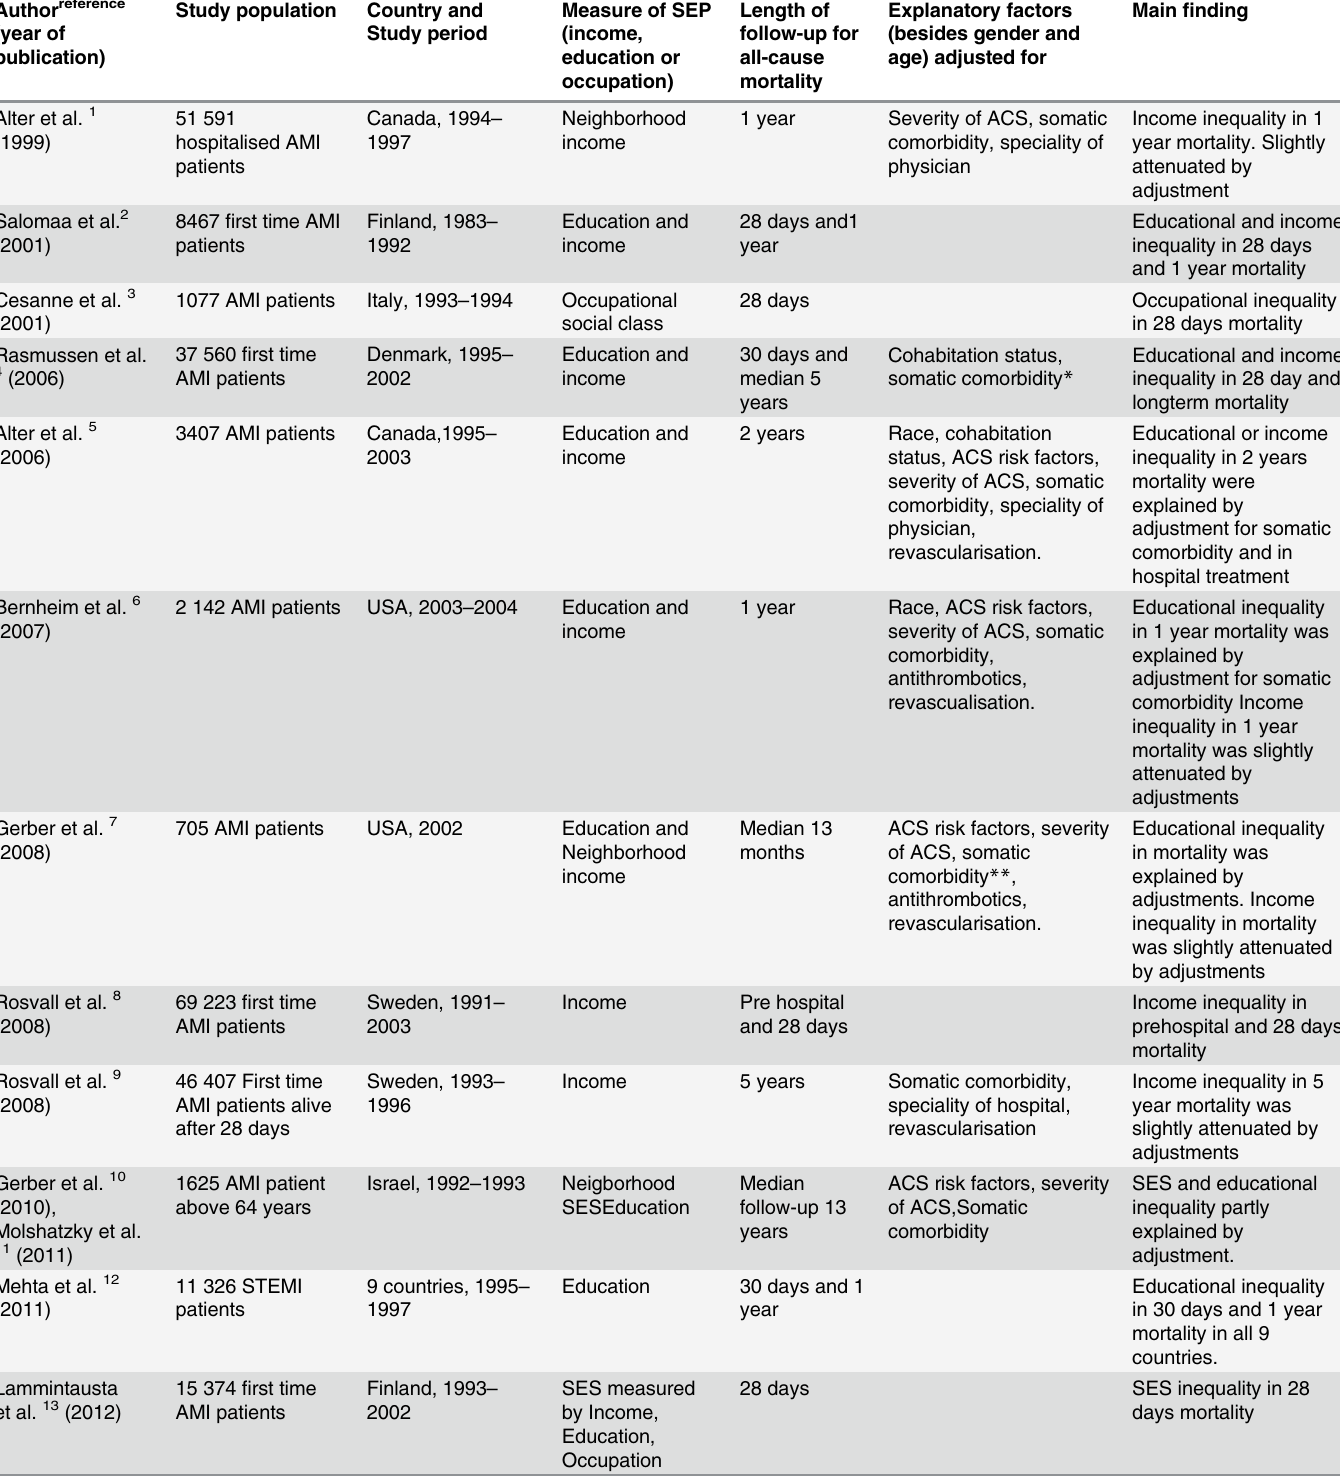
Table 1. Studies exploring the association between socioeconomic position (SEP) and survival after incident Acute Coronary Syndrome